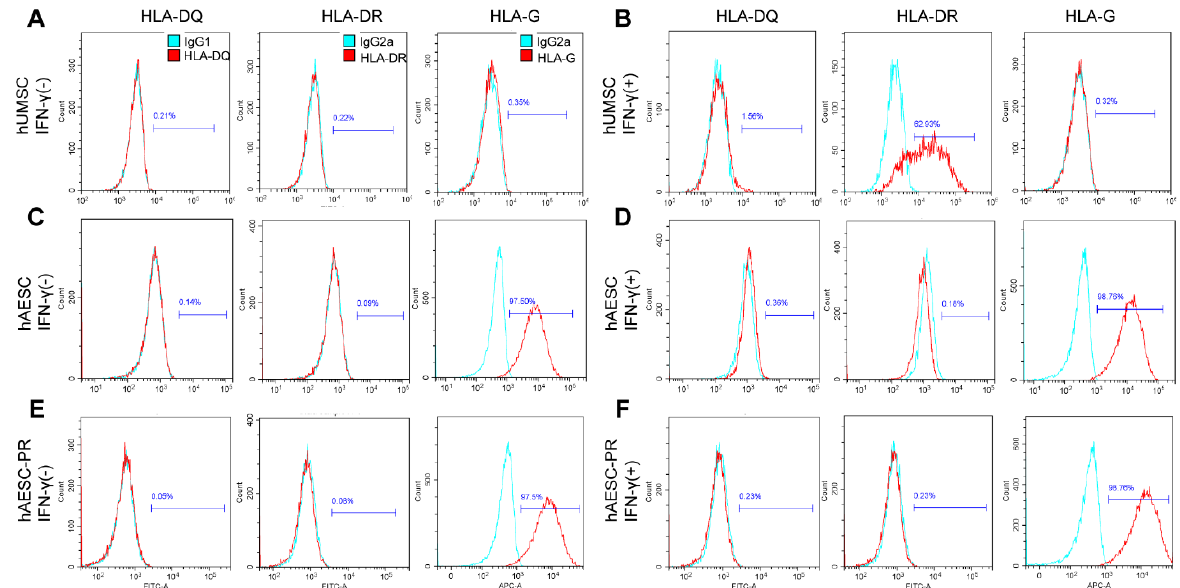
Figure 3. Consistent low immunogenicity in hAESCs and hAESCs − –PR − –like cells under normal and proinflammatory conditions. Flow cytometry analysis of HLA–DQ, HLA–DR, and HLA–G in human umbilical cord mesenchymal stem cells (hUMSC), hAESCs, and hAESCs–PR–like cells in normal culture medium ( A , C , E ) or with 10 ng/mL IFN– γ treatment for 72 h ( B , D , F ), indicating consistent low immunogenicity in hAESCs and their derived PR–like cells under normal and proinflammatory conditions. Representative histograms of HLA–DQ, HLA–DR, and HLA–G are shown in red, and the isotype controls are shown in blue.